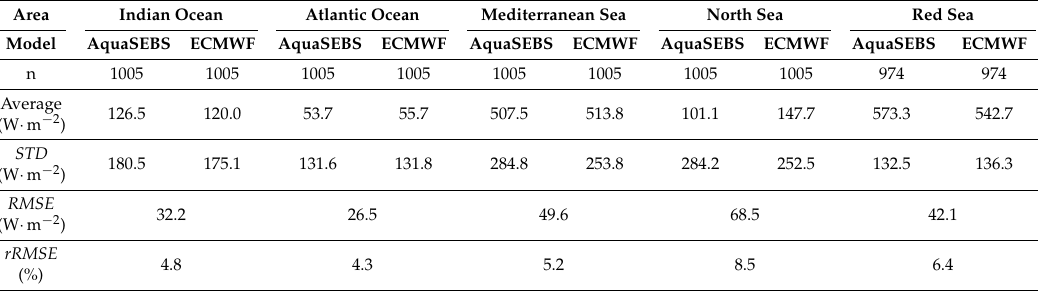
Table 2. Comparison of water heat flux values calculated by AquaSEBS (using the equilibrium temperature model) and ECMWF models (January 2010 to September 2012).